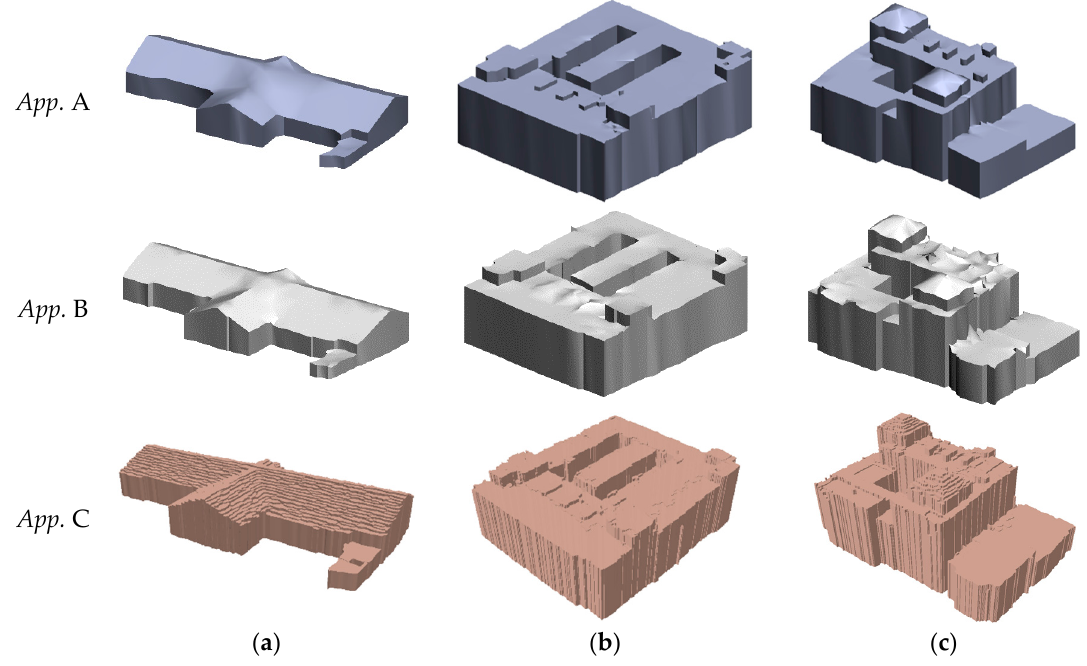
Figure 12. Comparison of Approaches (abbreviated as App. ) A, B, and C: ( a ), ( b ), and ( c ) the reconstructed roof models of Buildings 1, 2, and 3, respectively.